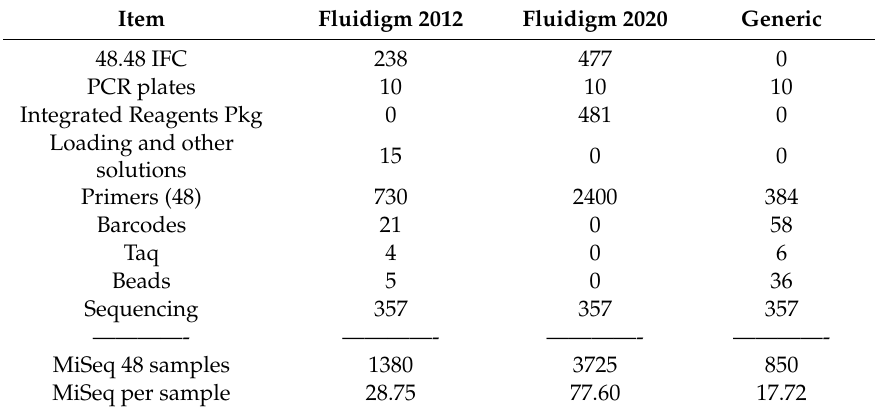
Table 7. Cost analysis for amplicon sequencing for di ff erent chemistries for 48 plate reactions.